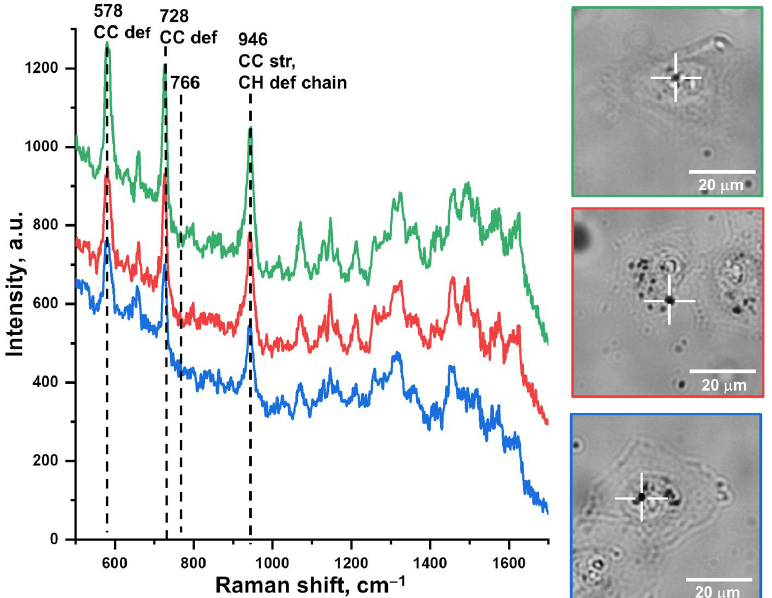
Figure 6. SERS spectra recorded from the nanoparticle agglomerates in different randomly selected HeLa cells. The inset shows the optical images of the studied cells and the points of spectra acquisition. In the bands description, def. means deformation and str. means stretching.